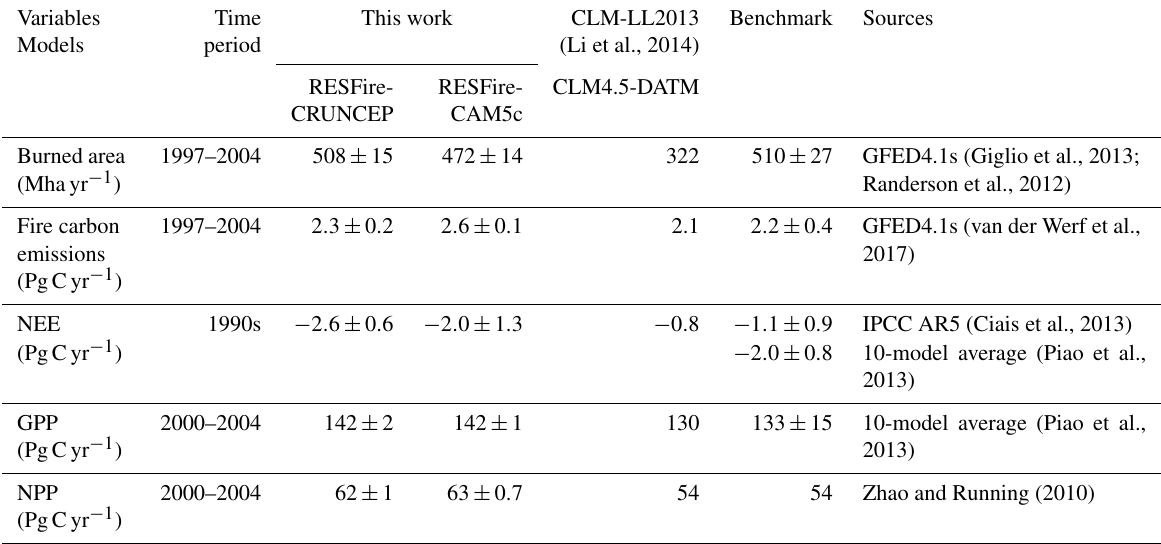
Table 3. Comparison of fire and carbon budget variables between CESM-RESFire simulations and previous studies and benchmarks. Variables Time This work CLM-LL2013 Benchmark